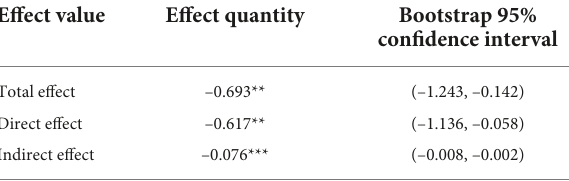
TABLE 6 Analysis results of mediating